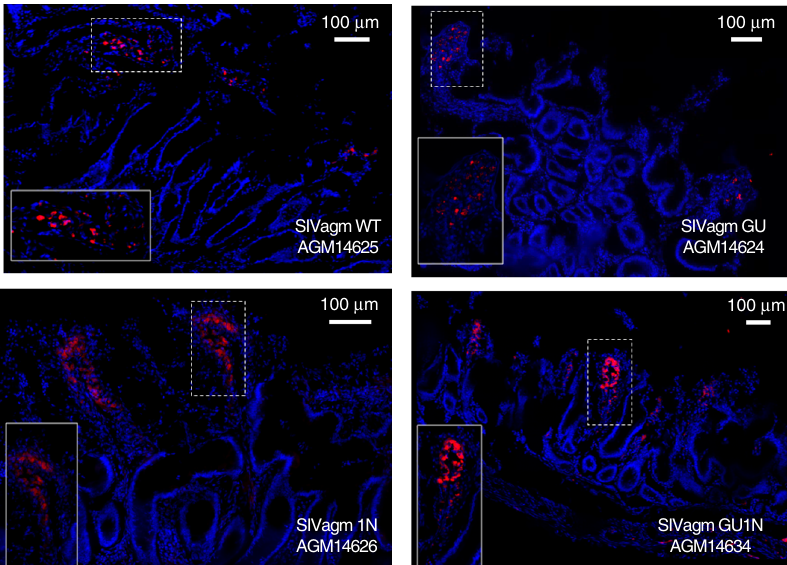
Fig. 8 Detection of IL-18 production in the gut. Sections of jejunum from the indicated animals were stained for IL-18 (red) and DAPI total nucleus (blue) and analyzed by confocal microscopy. The picture represents the distribution of IL-18 + cells in the gut of one chronically infected AGM per group. A representative picture out of 2 – 3 sections taken per monkey is